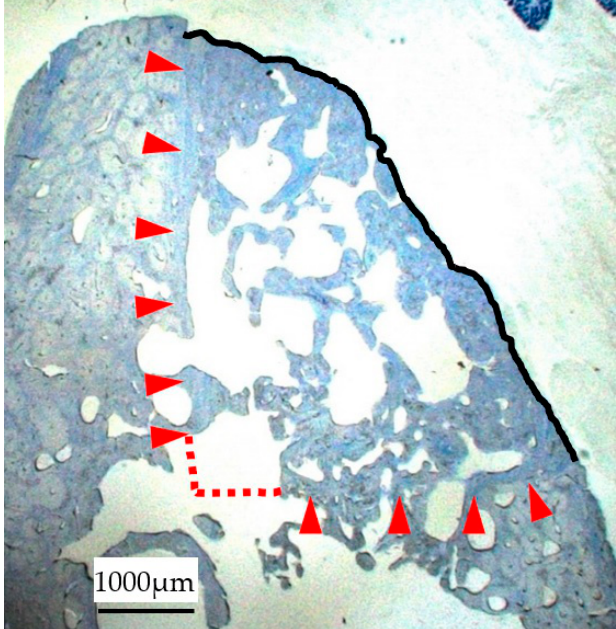
Figure 5. RBA measurement. The acquired image of the TB-stained sections was used to measure RBA, which is done by tracing the perimeter of the newly formed bone (black line) as well as the border between the original host and regenerated cortical bone, as determined by the shading difference in the TB staining (red arrows).